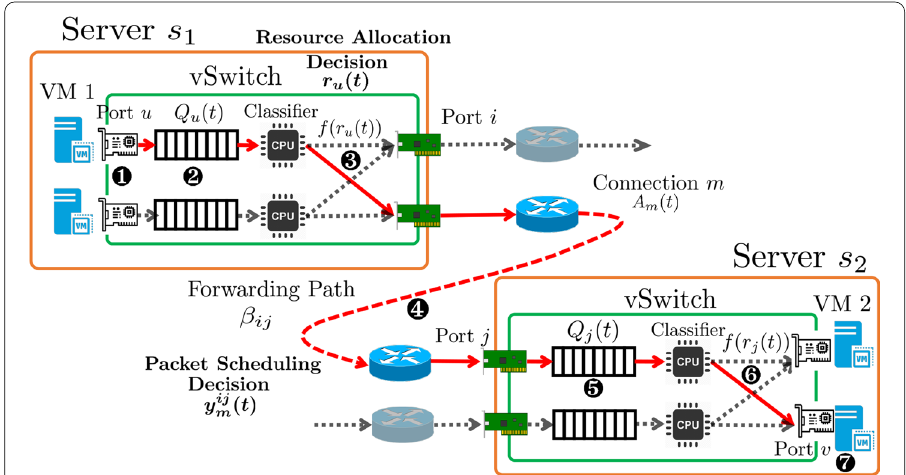
Fig. 3 An example of packet forwarding in edge and cloud data